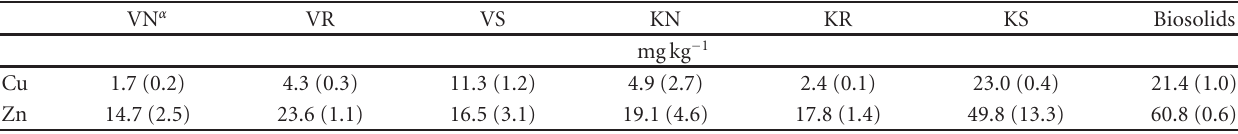
Table 2: Extractions of Cu and Zn in mgkg − 1 by HCl/HNO 3 in soils, spoil, and biosolids.